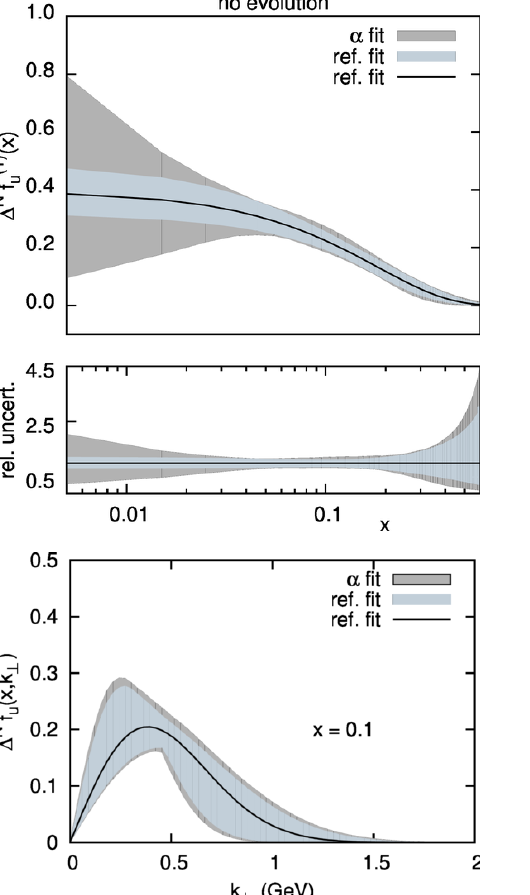
Figure 5 . The extracted Sivers distributions for u = u v + (cid:22) u and d = d v + (cid:22) d . Upper panels: the (cid:12)rst moments of the Sivers function, eqs. (3.1) and (3.4), are shown versus x . Middle panel: relative uncertainties, given by the ratio between the upper/lower border of the uncertainty bands and the best-(cid:12)t curve for the reference (cid:12)t. Lower panel: the Sivers functions, eqs. (2.1), is shown versus k ? , at x = 0 : 1. Here we have no Q 2 dependence. The shaded bands correspond to our estimate of 2 (cid:27) C.L. In all panels, the light blue bands correspond to the uncertainties of the reference (cid:12)t (only N and (cid:12) free parameters), while the large grey bands correspond to the uncertainties for the u ( d ) u ( d ) (cid:12)t which includes also the (cid:11) u and (cid:11) d